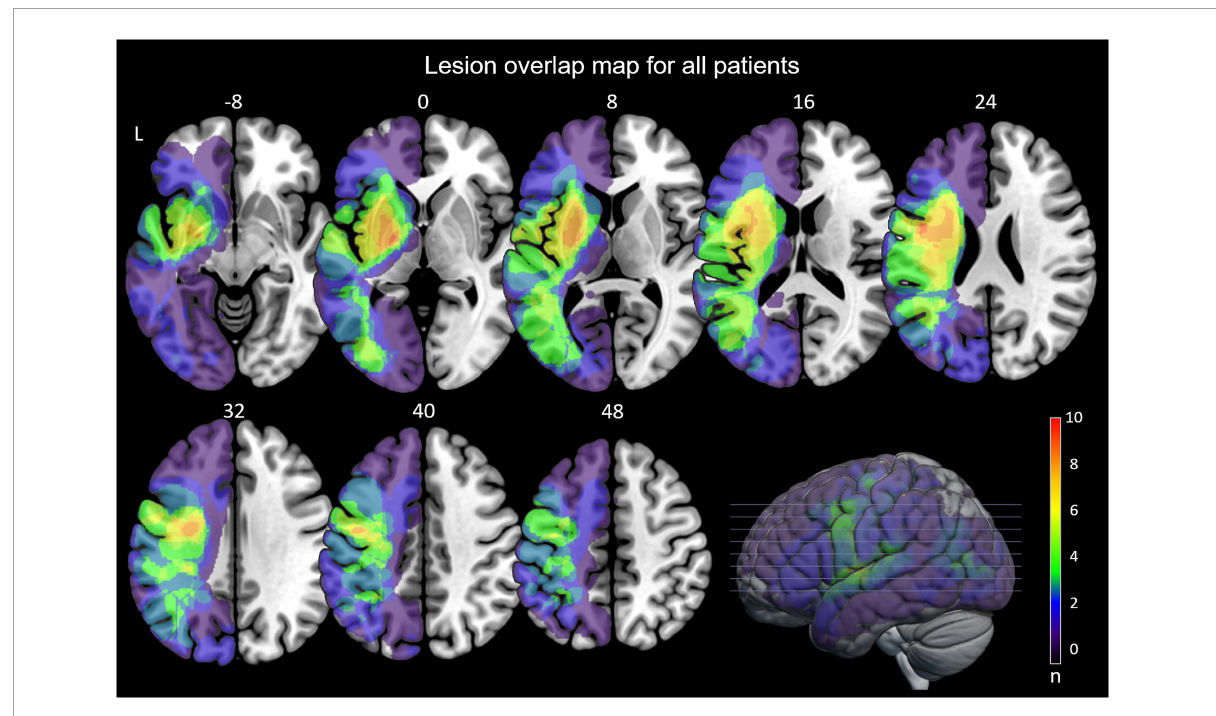
FIGURE2 Anatomical overview. Lesion overlap maps for all patients. Numbers are z -coordinates given in MNI stereotaxic space from z = –8 to z = 48, color coding indicates number of overlapping lesions. L, left, n, number of overlaps.